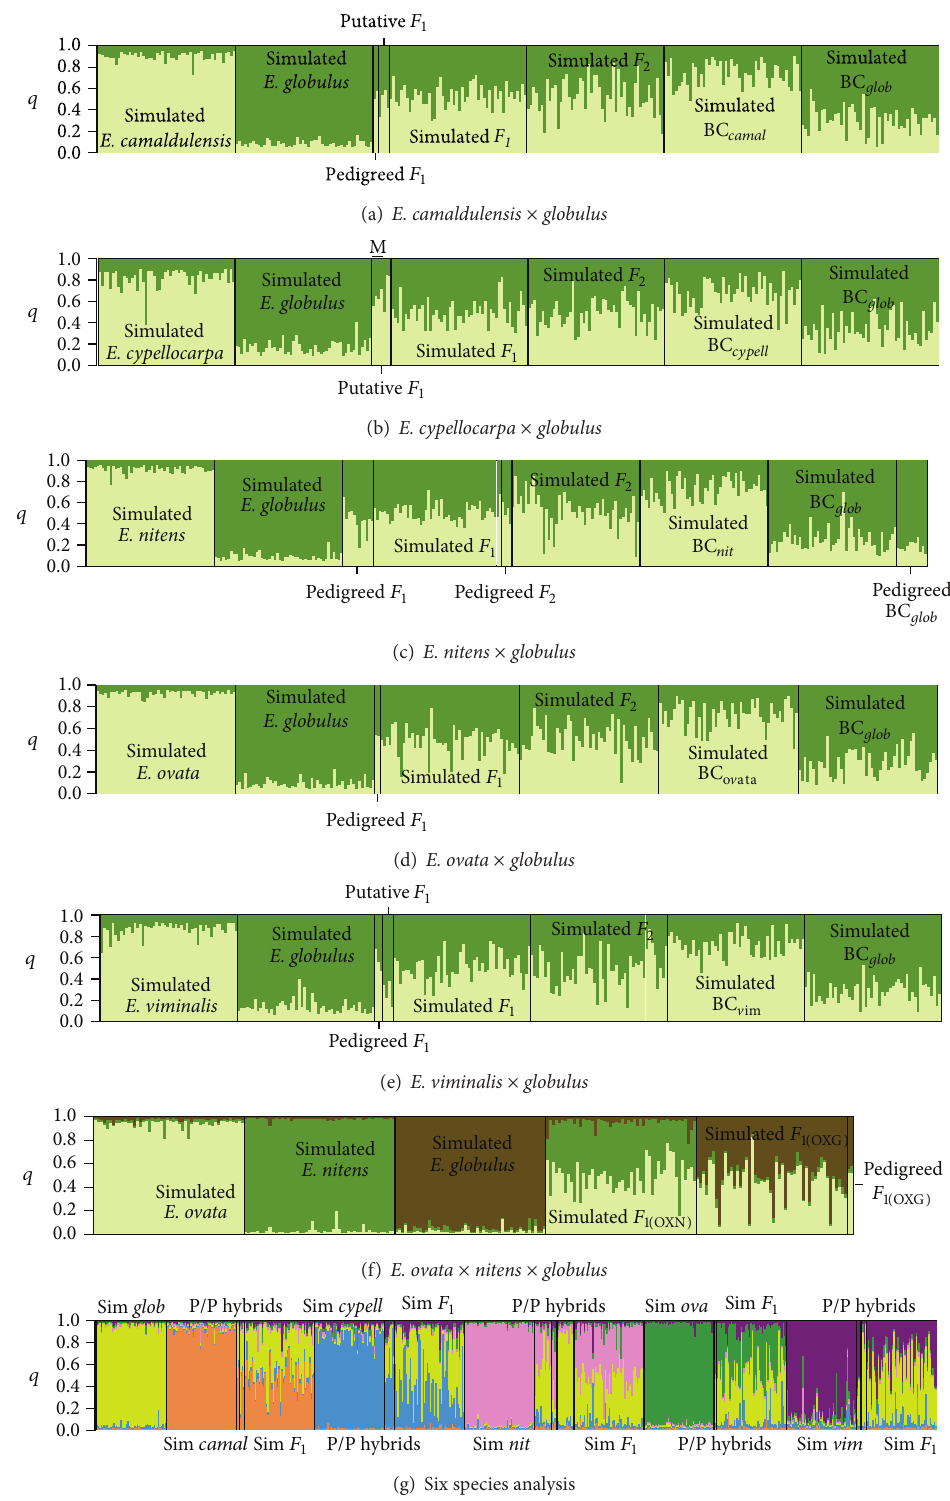
Figure 3: Proportion of genotype membership ( 𝑞 ) of simulated, pedigreed, and putative hybrid individuals based on Bayesian cluster analysis. The real parental samples (not shown) were used to define the genetic clusters for each combination and showed between 98 and 100% affinity to their defined group. Each simulated generation consists of 50 individuals in each combination. Each individual is represented by a single vertical line that is partitioned based on its genotype affinities to the parental groups. Two species analyses are shown in (a) to (e), with three and six species analysis in (f) and (g), respectively. Abbreviations in (g): P/P hybrids = pedigreed and putative hybrids; Sim = simulated; camal = E. camaldulensis ; cypell = Eucalyptus cypellocarpa ; glob = E. globulus ; nit = E. nitens ; ova = E. ovata ; vim = E. viminalis . In (b) the bar with the “M” indicates samples from the Mallacoota population that are referred to in the